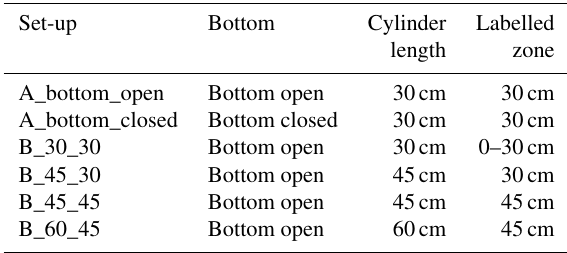
Table 1. Modelled